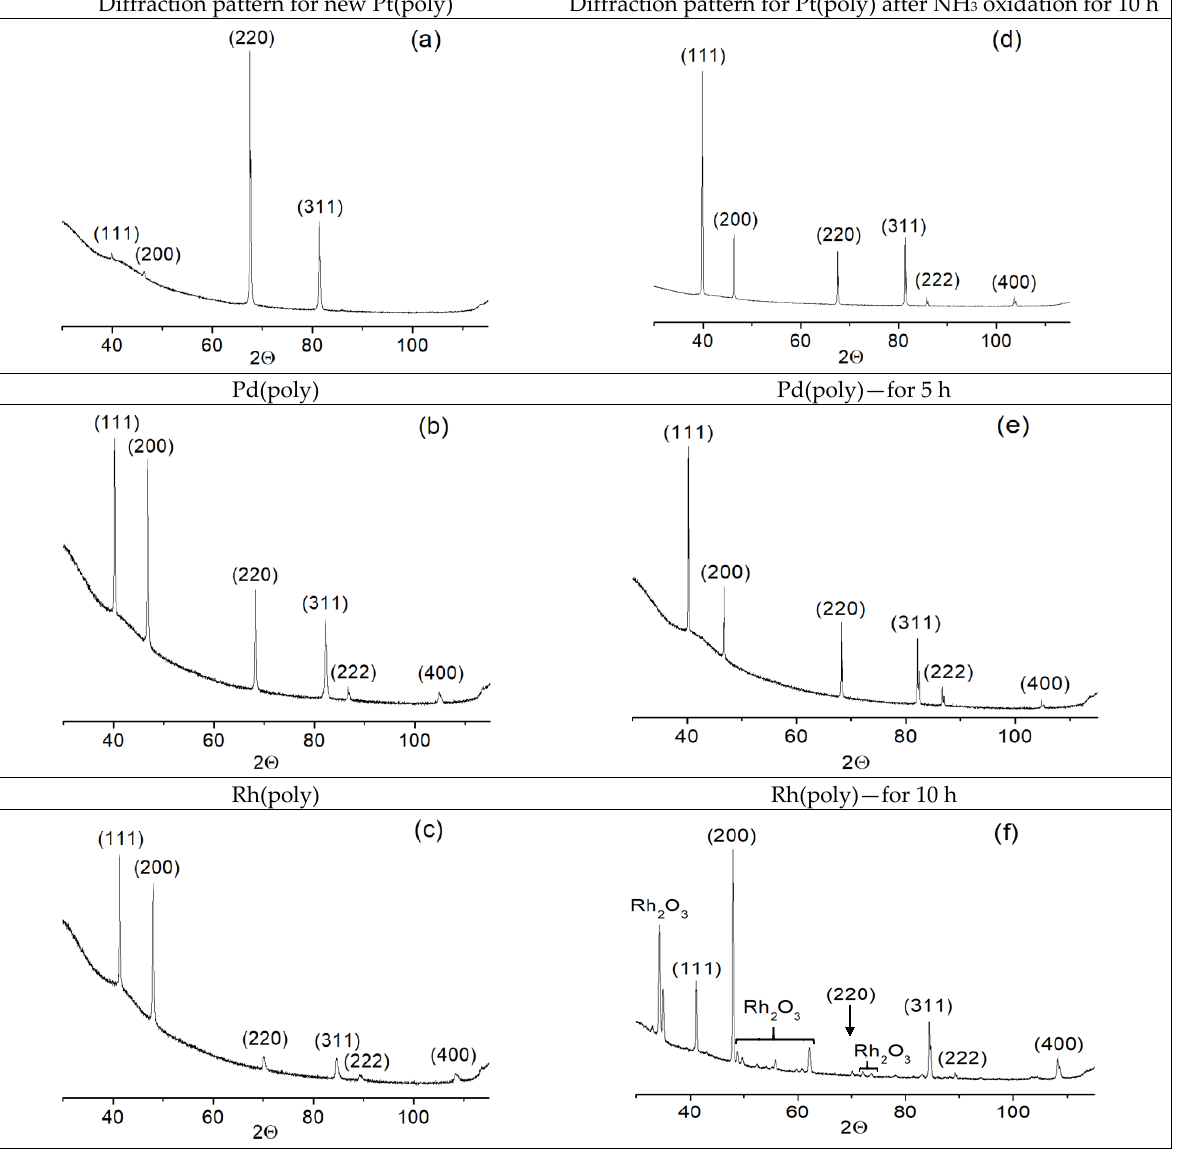
Figure 8. X-ray diffraction patterns for the new foils ( a – c ) as well as after NH 3 oxidation with air at 1133 K ( d – f ) during 5 ( e ) and 10 h ( d , f ) for the Pt(poly) ( a , d ), Pd(poly) ( b , e ) and Rh(poly) ( c , f ).